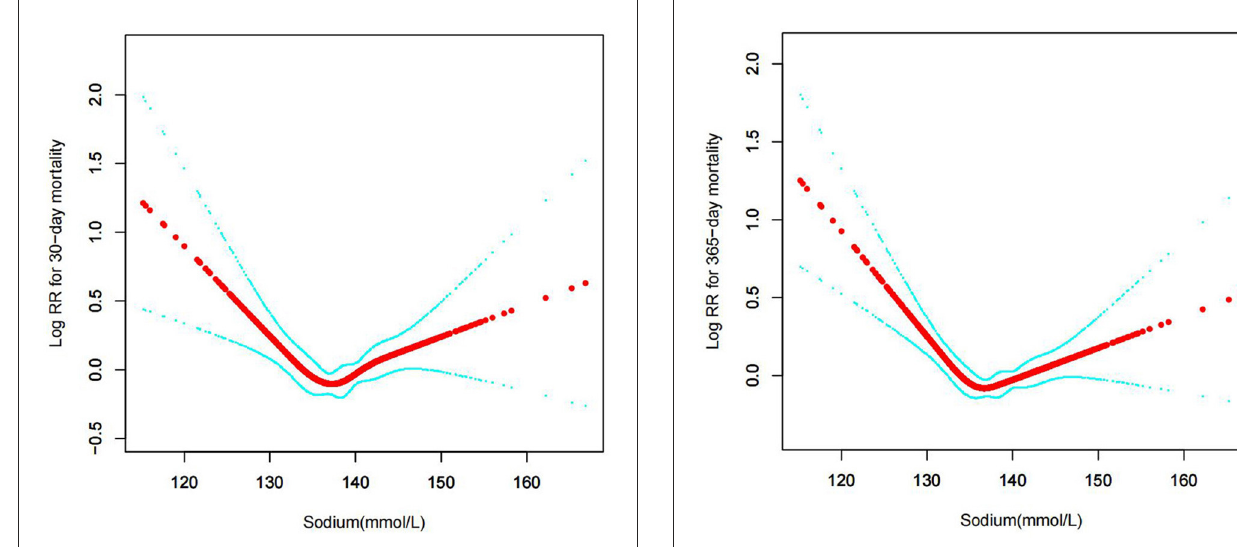
FIGURE7 Association between serum sodium levels and 30-day all-cause mortality (After adjustment for other covariates). A generalized additive model (GAM) revealed a threshold, non-linear relationship between serum sodium levels and 30-day all-cause death. U-shaped relationships were observed after adjustment for other covariates by spline smoothing plot. The smooth curve fit between variables is shown by a solid rad line. The 95% confidence interval from the fit is represented by imaginary blue lines.